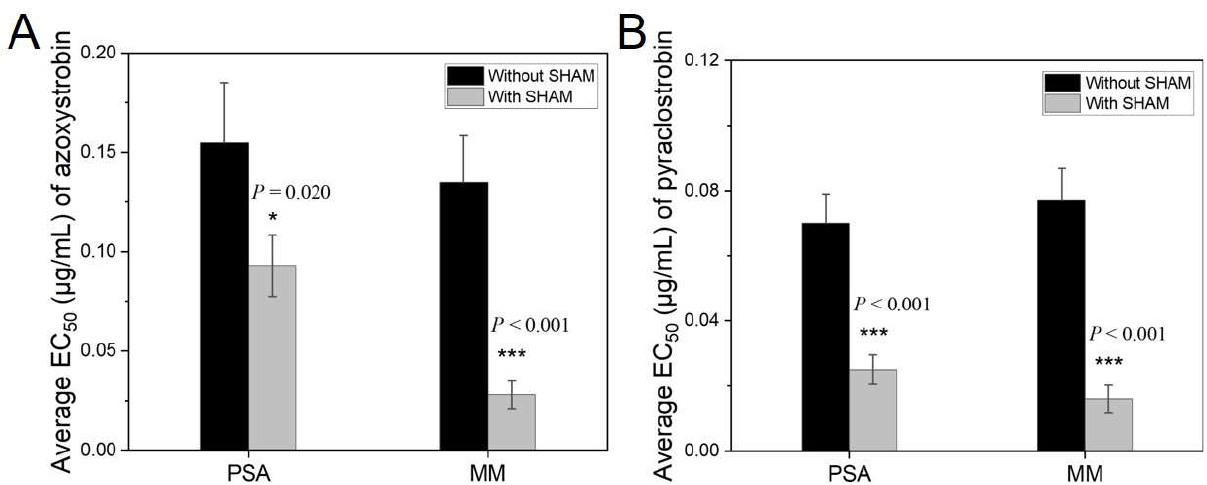
Figure 5. Effects of SHAM at 10 μg/mL on EC 50 values of azoxystrobin ( A ) and pyraclostrobin ( B ) against mycelial growth of U. virens on PSA and MM. Values are means of ten isolates; error bars represent standard errors of the mean. Asterisk (* or ***) indicates that there is a significant difference ( p < 0.05 or p < 0.001) between EC 50 values with and without SHAM by paired t test. PSA, potato sucrose agar; MM, minimal medium.